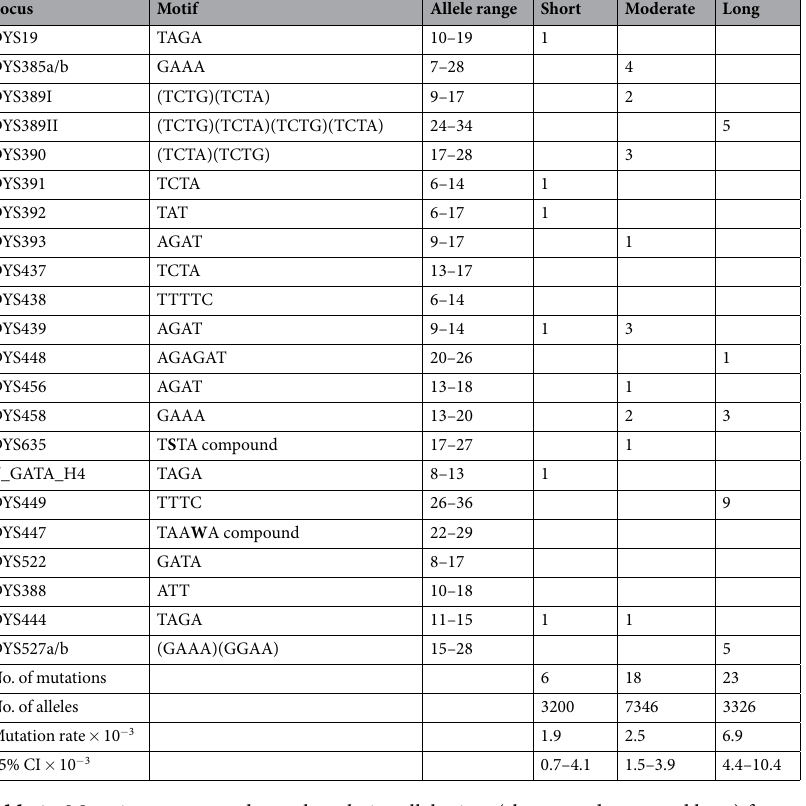
Table 3. Mutation counts and rates by relative allele sizes (short, moderate, and long) for each locus. The allele sizes are generally categorized into 25%, 50%, and 25% quantiles for short, moderate and long allele sizes,